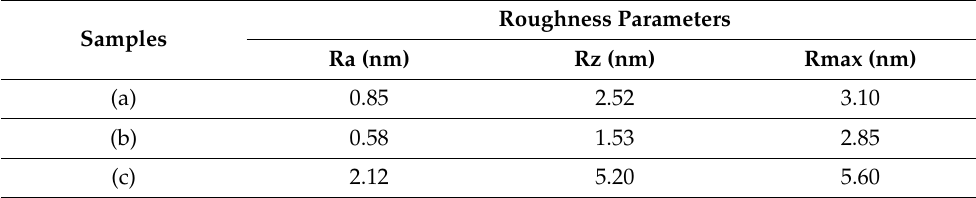
Table 1. The roughness parameters were evaluated on 2D AFM images in Figure 7.